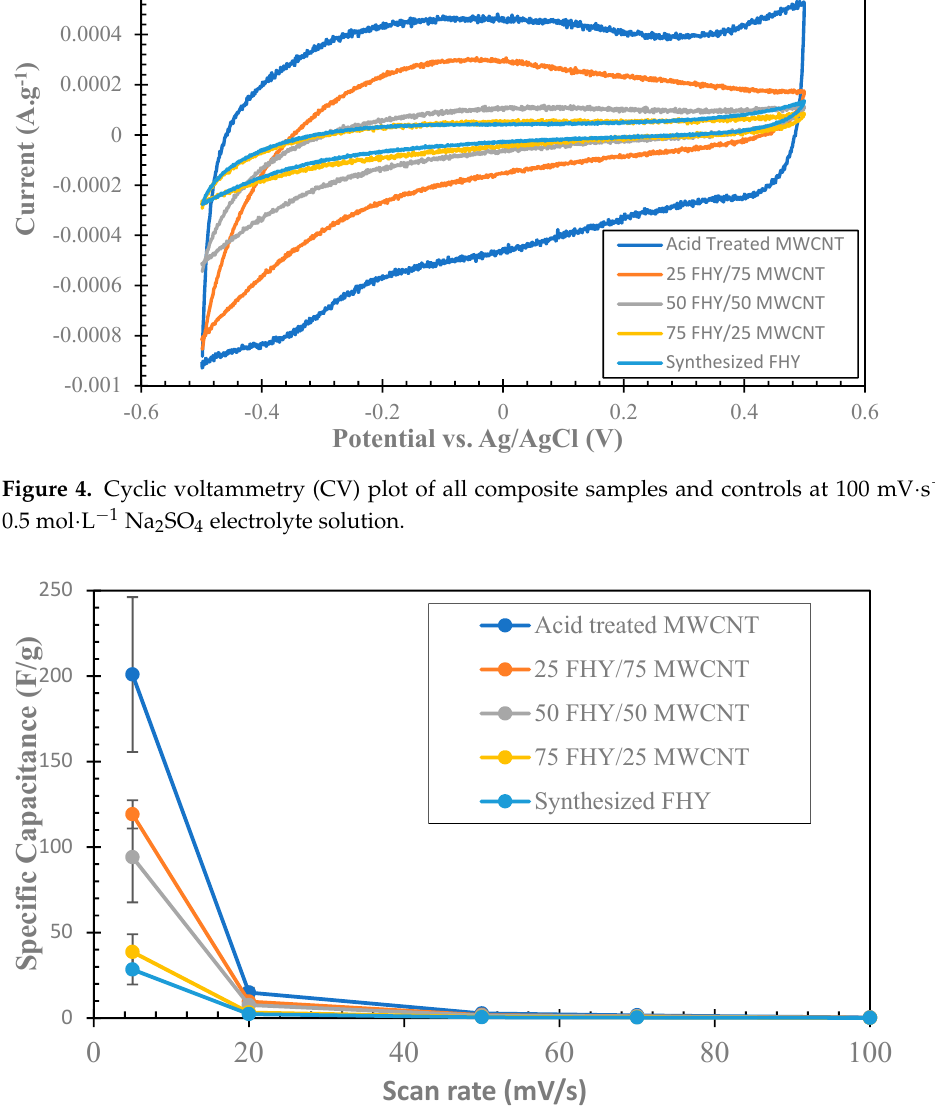
Figure 5. Specific capacitance of all composite samples and controls at various scan rate. Error bars reveal the standard deviation obtained from triplicate electrodes measurements.